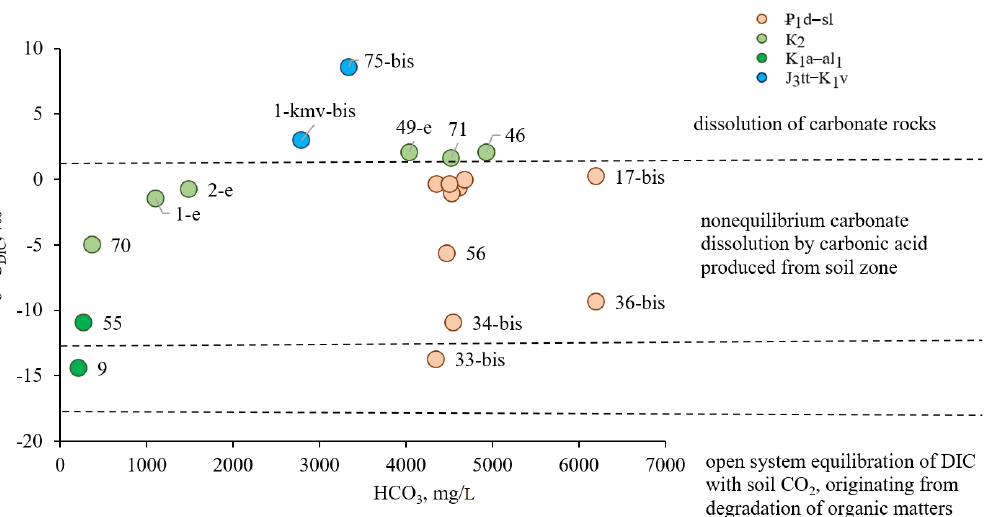
Figure 11. Relationship between the content of δ 13 C DIC and the concentration of bicarbonate in natural mineral water of the Essentuki field.